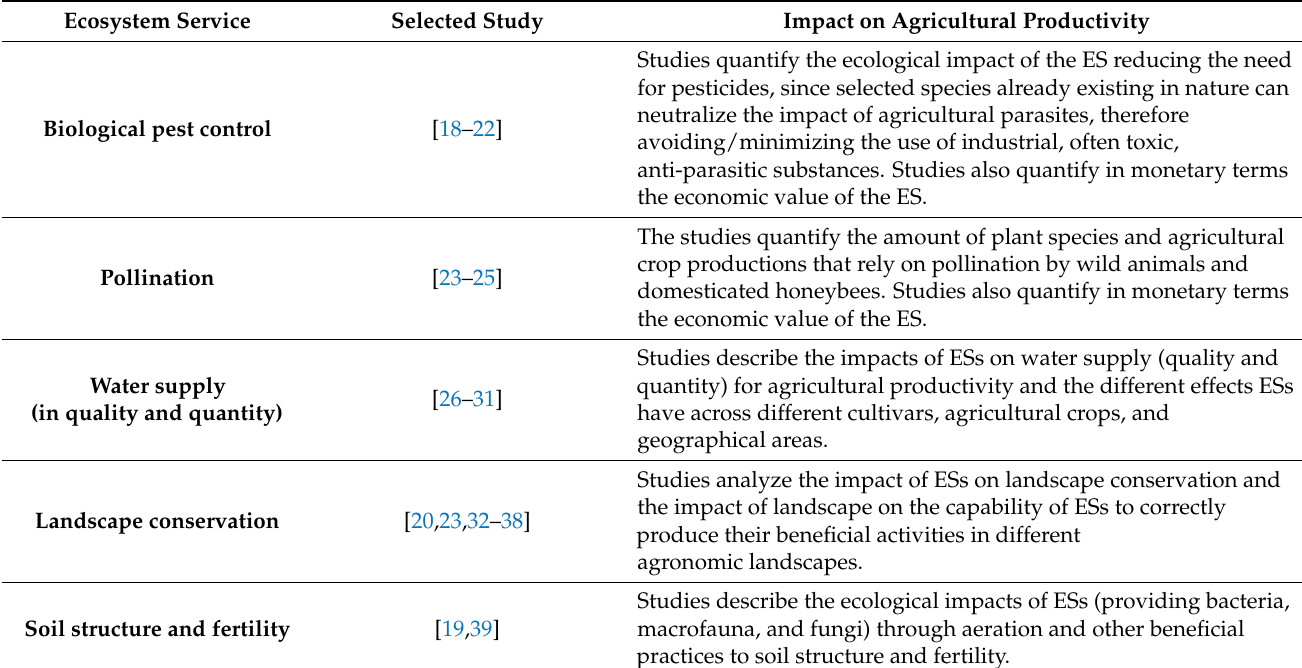
Table 2. Selected Studies on Ecosystem Services and Agricultural